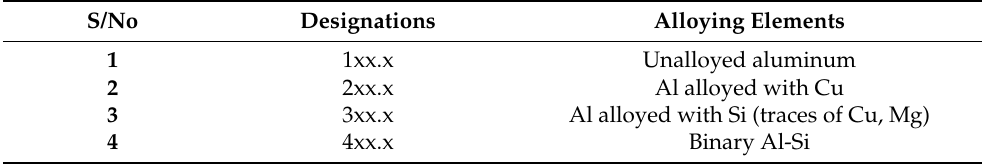
Table 3. Designation of cast Al alloys